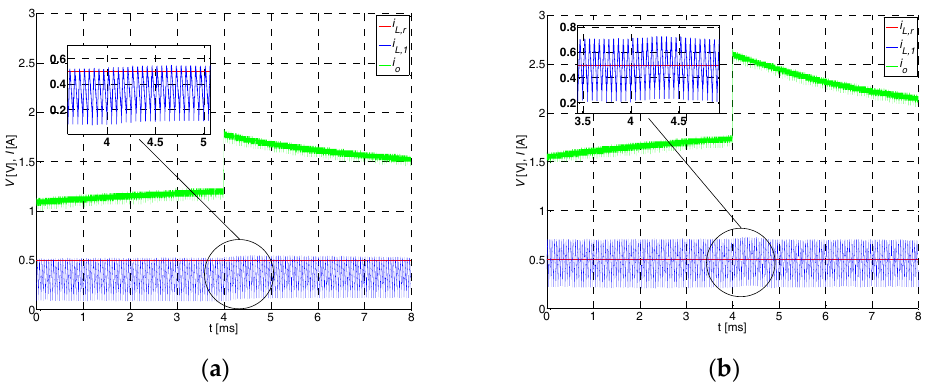
Figure 10. Phase 1 current i L ,1 response with reference current i L , r = 0.5 A and load change from 3 Ω to 2 Ω without observer ( a ) and with observer ( b ).